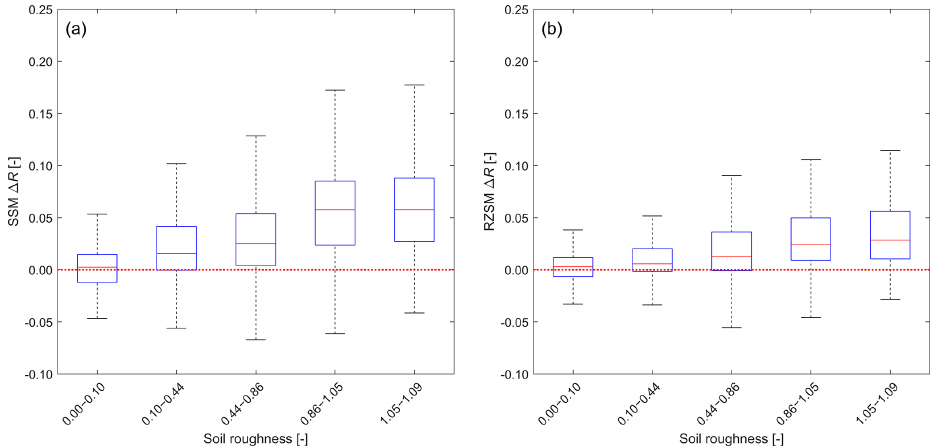
Figure 8. As in Fig. 6 but for (cid:49)R as a function of microwave soil roughness.